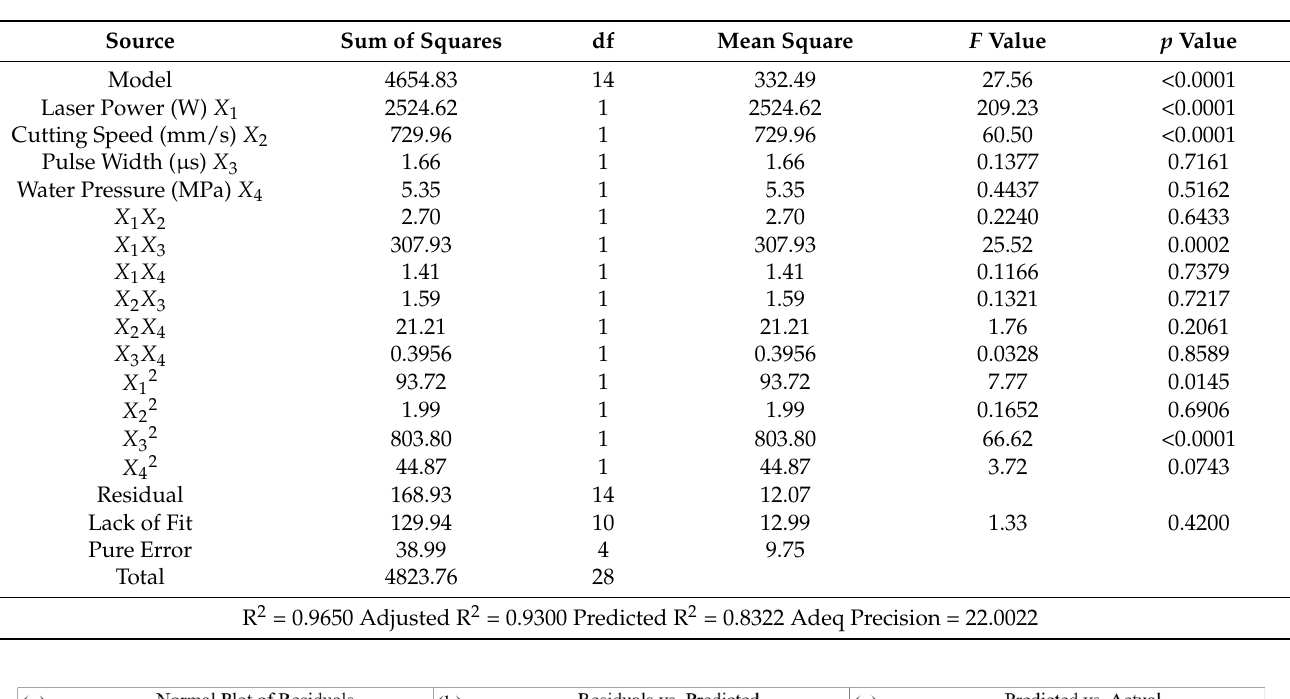
Table 9. ANOVA of the regression model for top width.